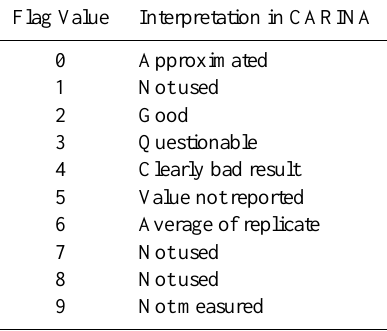
Table 3. Summary of data quality flags used for CARINA cruise files. For the data products the flag list was reduced to 0, 2 and 9 (see text).